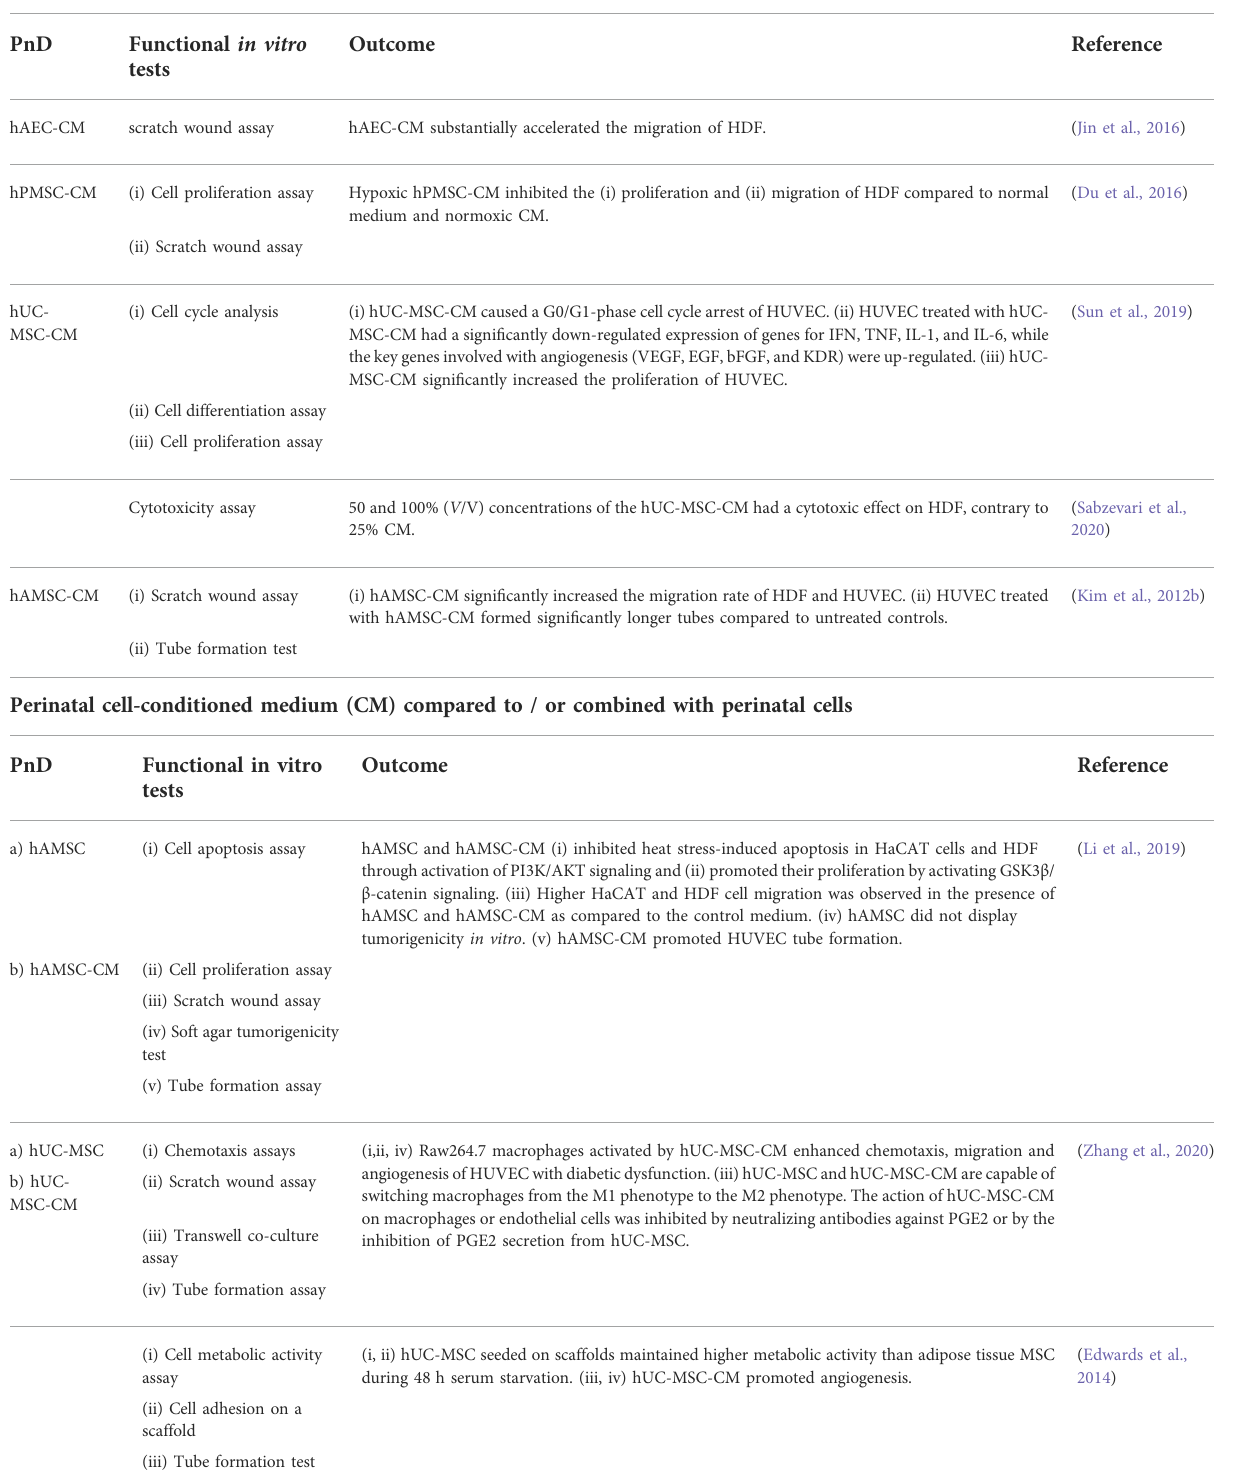
TABLE 2 Functional tests on perinatal cell-conditioned medium (CM) alone or compared to/or combined with perinatal cells. Perinatal cell-conditioned medium (CM) PnD Functional in vitro Outcome tests hAEC-CM scratch wound assay hAEC-CM substantially accelerated the migration of HDF.